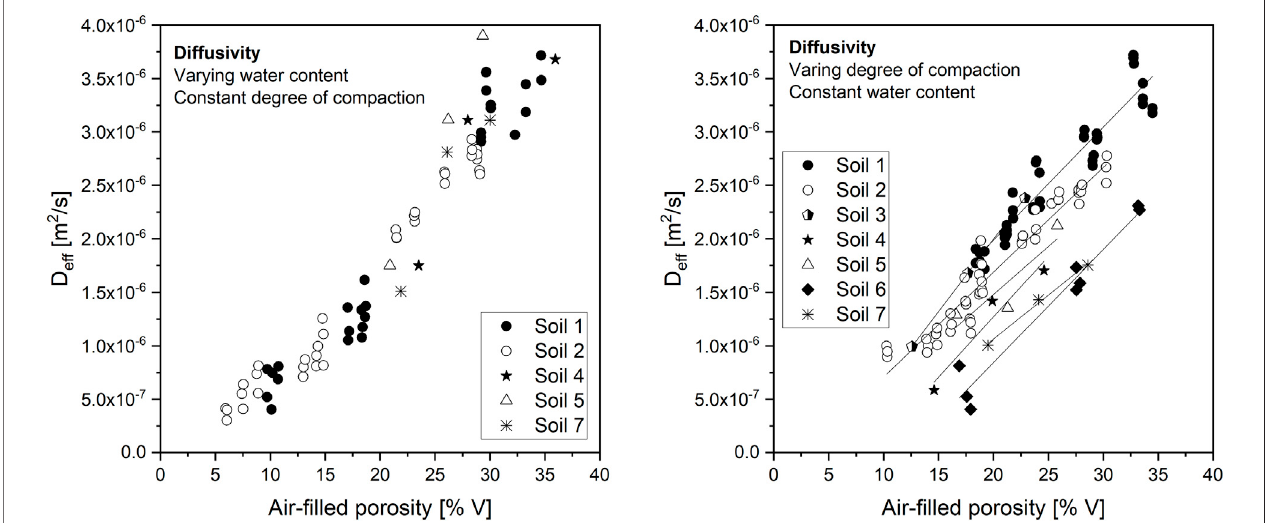
FIGURE 6 | Effective gas diffusivity (D eff ) in relation to air- fi lled porosity ( ε a ), adjusted by soil moisture (left) and by degree of compaction (right) in different sandy candidate MOL soils. Fluid = arti fi cial land fi ll gas mixture. Adapted from Gebert et al. (2019).